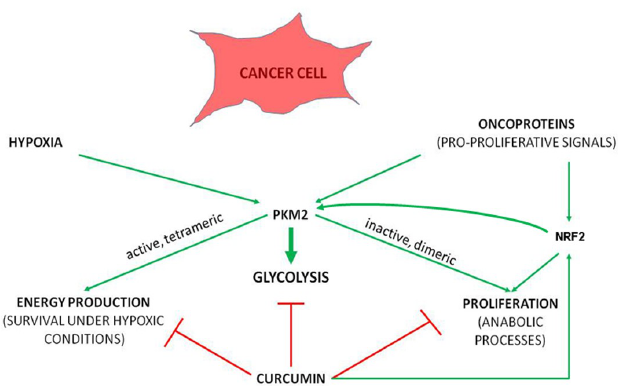
Figure 2. The principle underlying antitumorigenic effect of curcumin. Curcumin targets cellular processes central to the ability of cancer cell to survive by coordinately hindering aerobic glycolysis-dependent anabolic processes and energy production, despite of stimulating NRF2.